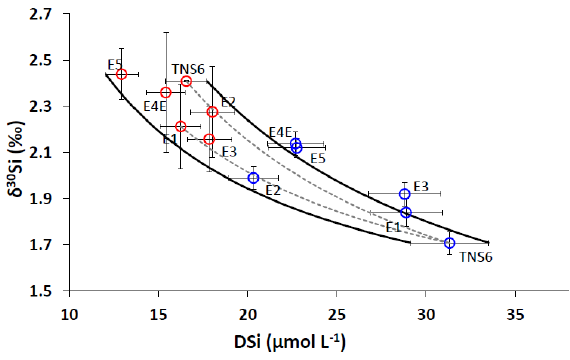
Figure 5. Potential mixing curves between TNS6-WW and the dif- ferent meander ML water masses; WW is in blue and the ML is in red. The two end-members are identified by black curves. The two grey dashed lines represent the mixing curves between TNS6-WW and TNS6-ML and between TNS6-WW and E1-ML, which may explain the Si properties of E1-WW and E2-WW respectively. The ML averages and error bars were calculated based on the median values and interquartile range for each station, while the “central value” was defined using the salinity threshold method for